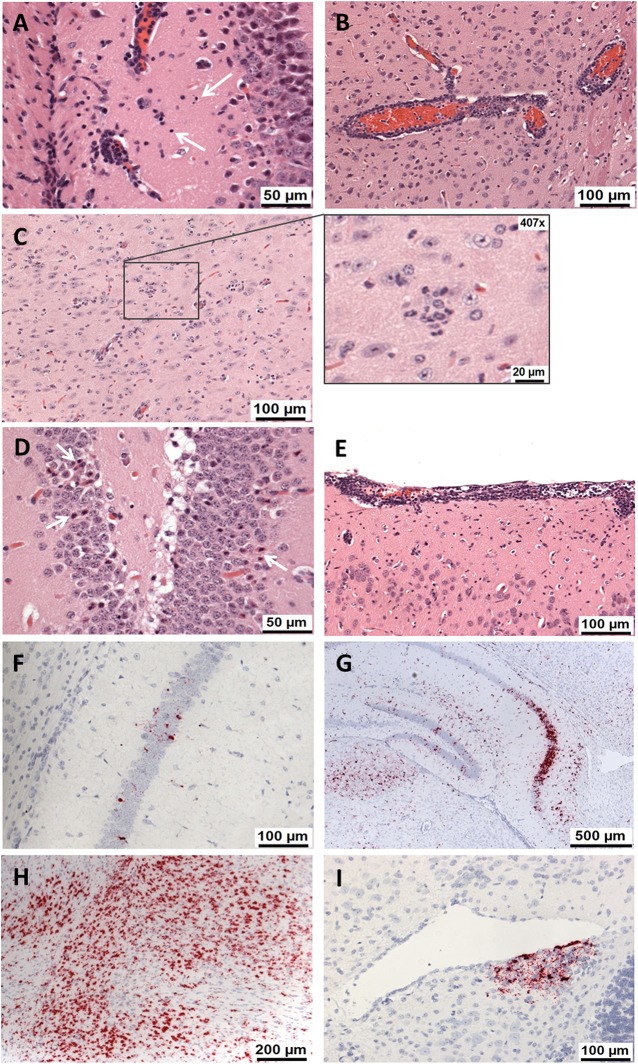
Histological and RNA in situ hybridisation findings in the brain of ZIKV-challenge A129 mice.(A) Scattered nuclear fragmentation in the hippocampus (Animal 86756, 106 pfu ZIKVAS, day 7). (B) Perivascular cuffing by mononuclear cells (Animal 86762, 106 pfu ZIKVAS, day 7). (C) Scattered polymorphonuclear cells (PMNs) in the neuropil, including higher magnification of PMNs (Animal 86722, 106 pfu ZIKVAF, day 7). (D) Diffuse neuronal degeneration in Ammon’s horn of hippocampus (Animal 86724, 106 ZIKVAF, day 6). (E) Infiltration of inflammatory cells, mainly mononuclear, in the meninges (Animal 86765, 10 pfu ZIKVAF, day 7). (F) Occasional scattered cells staining positive for viral RNA in the hippocampus (Animal 86780, 106 pfu ZIKVAF, day 3). (G) Patchy to diffuse positive staining for viral RNA in the hippocampus (Animal 86783, 106 pfu ZIKVAF, day 5). (H) Strong positive staining for viral RNA (Animal 86740, 10 pfu ZIKVAF, day 7). (I) Focus of positively staining cells for viral RNA in sub-ependymal area of the fourth ventricle (Animal 86773, 106 ZIKVAS, day 5). A-E show sections stained with haematoxylin and eosin (H&E) and F-I show RNA in situ hybridisation images.